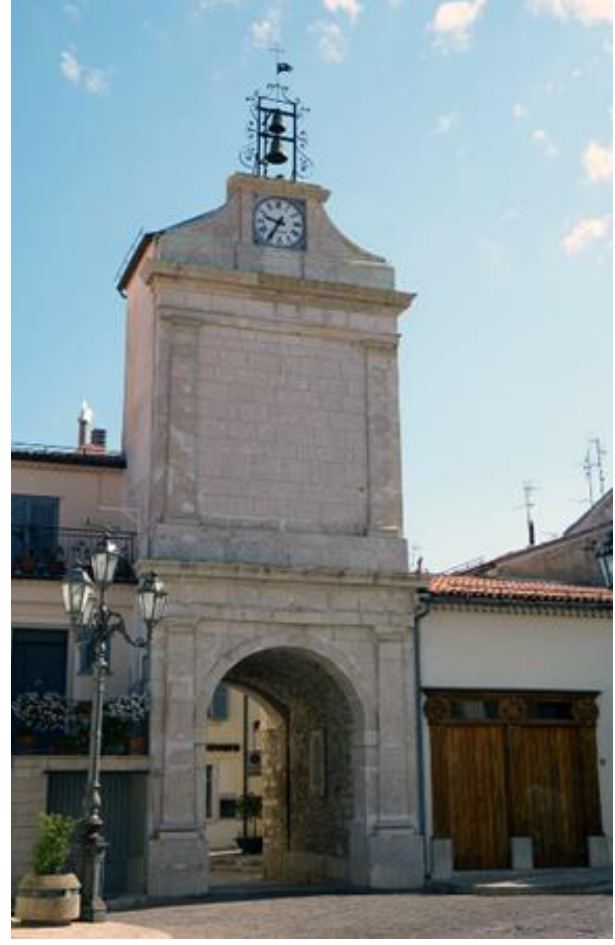
Figure 69. Pescopagano: “Porta della Sibilla” into the historical centre (photos by [35,36]).